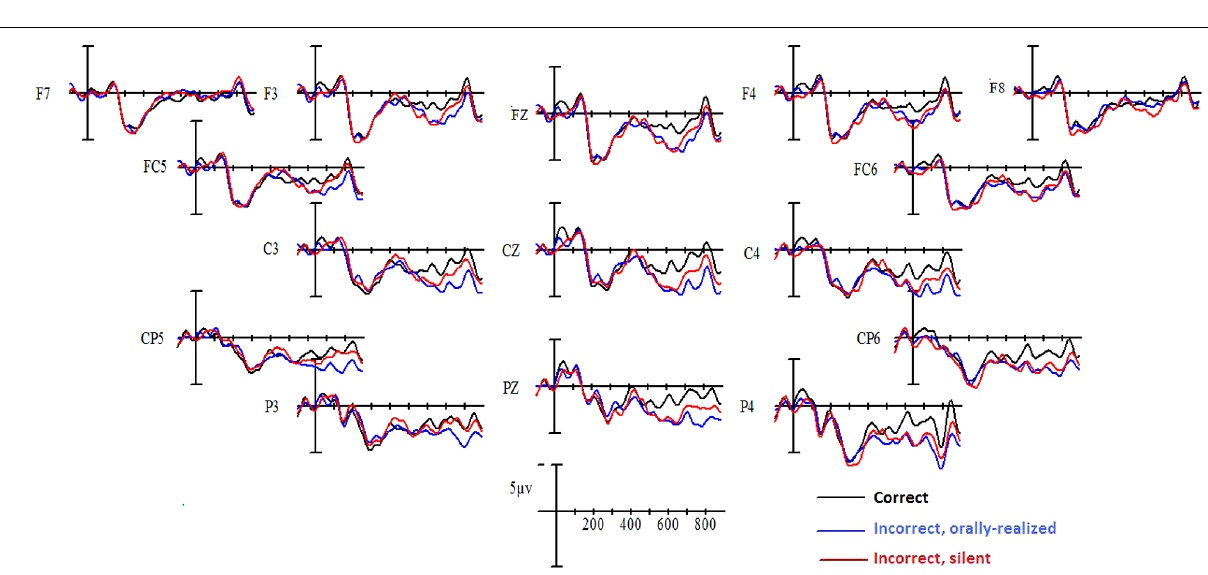
Frontiers in Psychology | Language